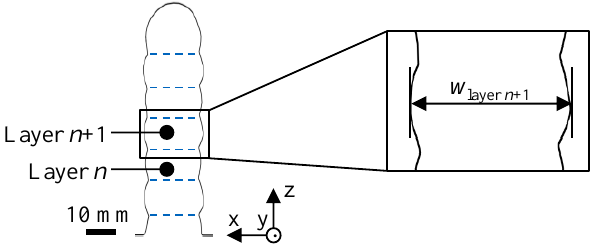
Figure 2. Example of a digitally cut wall with individual layers indicated by blue dashed lines.